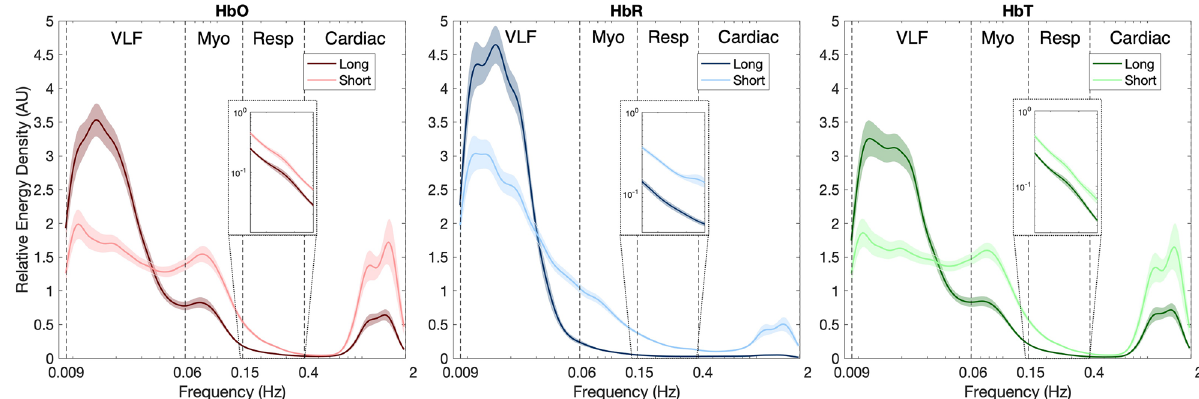
Figure 4. Differences in relative energy density ( rel ε ) between long- and short- source detector separation (SDS) measurements per biomarker. Colored lines represent mean of the data (channels, conditions and subjects), while associated shaded portions represent standard error of mean. Dashed black lines represent beginning and ending of very low frequency (VLF), myogenic (Myo), respiratory (Resp) and cardiac bands. The embedded plot represents log-transformed rel ε values of respiratory band (0.15 to 0.4 Hz). Figure generated using custom code in Matlab (MathWorks,